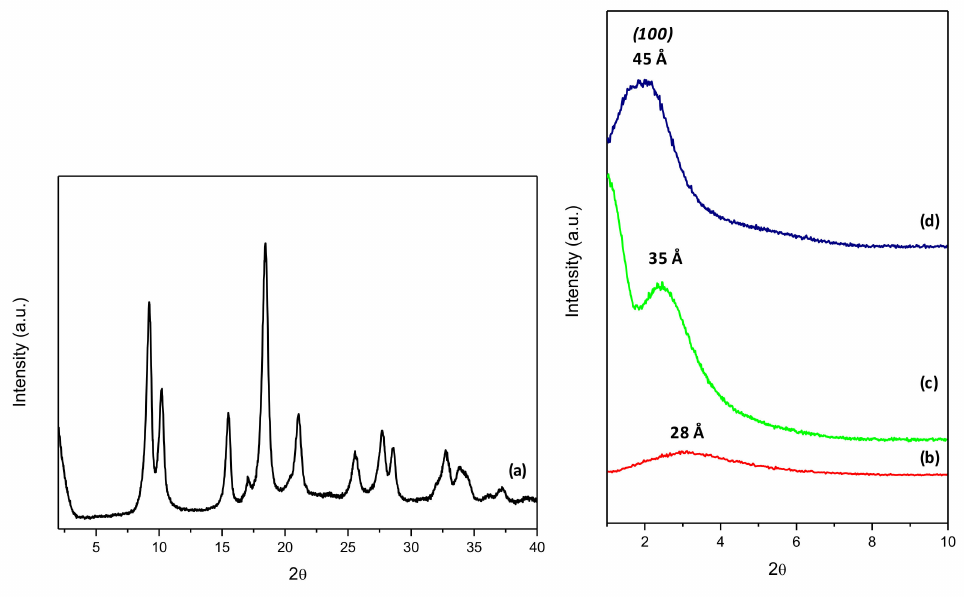
Figure 1. The X-ray di ff raction (XRD) patterns of hybrid materials: ( a ) MIL-53(Al), ( b ) Al-ITQ-EB, ( c ) Al-ITQ-HB and ( d )